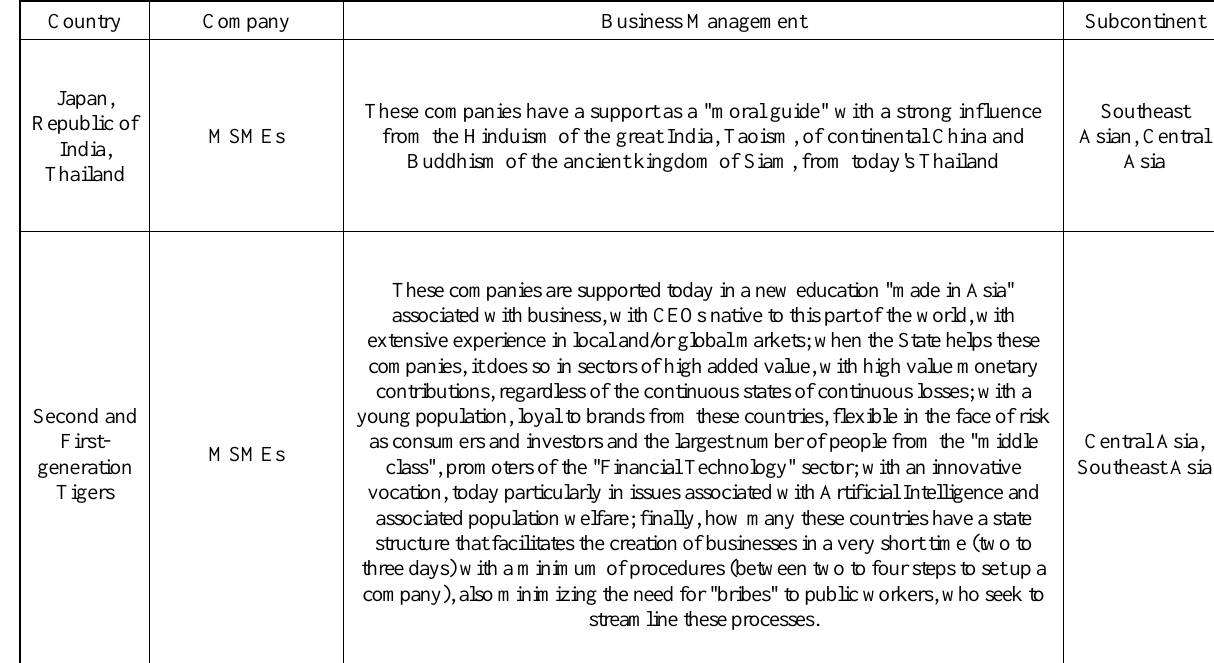
Table 2. Characteristics of post pandemic